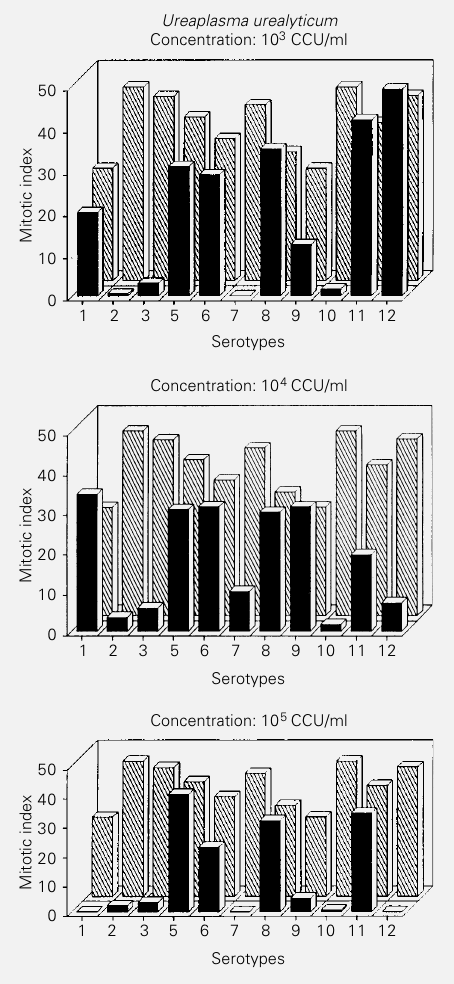
Figure 1 - Reduction of human lymphocyte mitotic index by U. urealyticum serotypes as a func- tion of concentration. CCU/ml = Color changing unit/ml. (cid:224) , Sero- type; ,